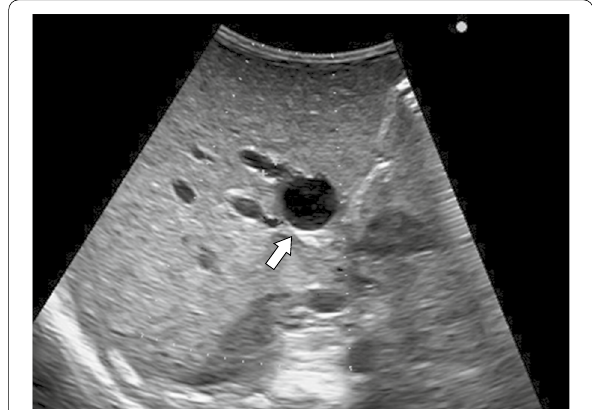
Fig. 1 Ultrasonography at 37 days of age showed a biliary cyst at the